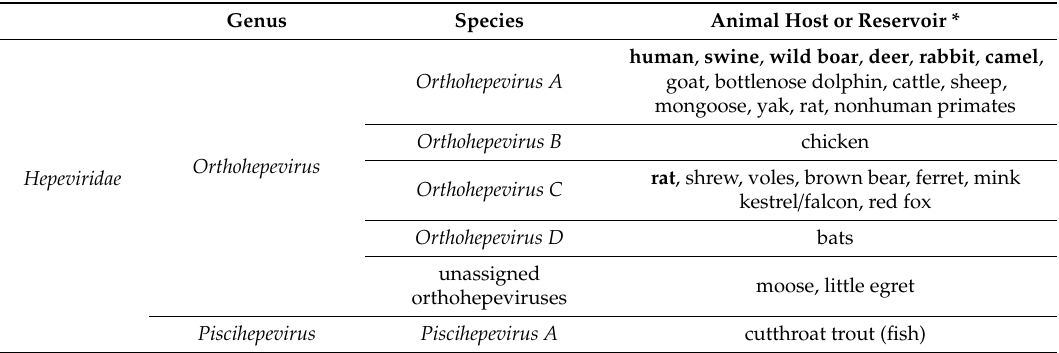
Table 1. Summary of known hosts, potential animal reservoirs, and known sources of orthohepeviruses for